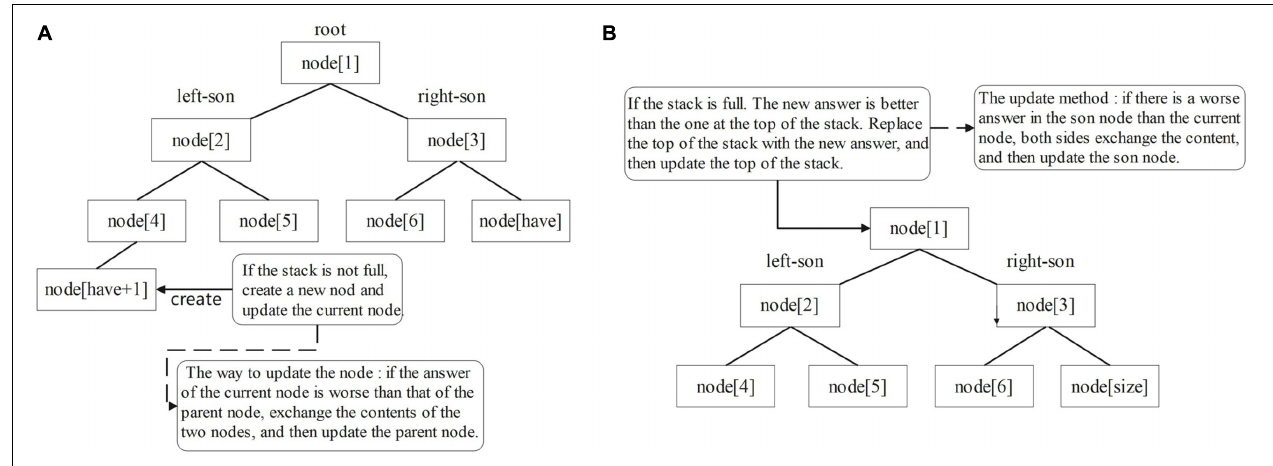
FIGURE 6 | Update process diagram of the min-heap: (A) from bottom to top and (B) from top to bottom.